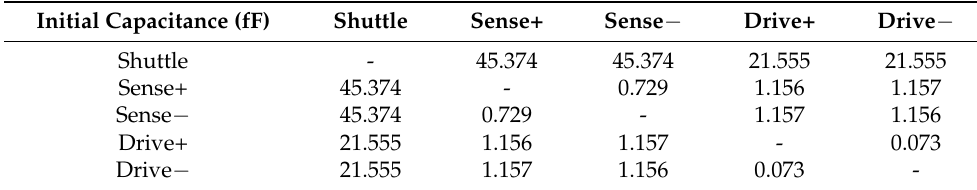
Table 3. Simulation result of capacitance array. Sense+, positive sensing port; Sense − , negative sensing port; Drive+, positive driving port; Drive − , negative driving port. Initial Capacitance (fF) Shuttle Sense+ Sense − Drive+ Drive − Shuttle - 45.374 45.374 21.555